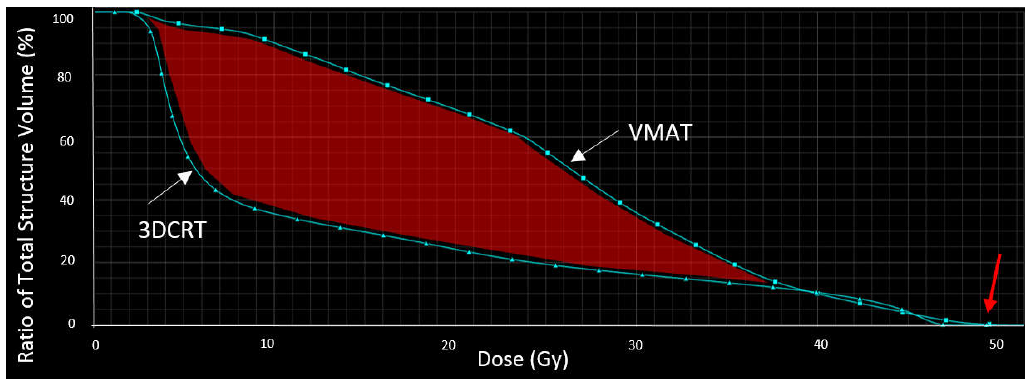
Figure 2. Dose-volume histogram of the dose delivered to the posterior fossa. Although the maximum dose is similar for both plans (red arrow), the average dose is higher in the VMAT plan compared to the 3DCRT plan (red surface).